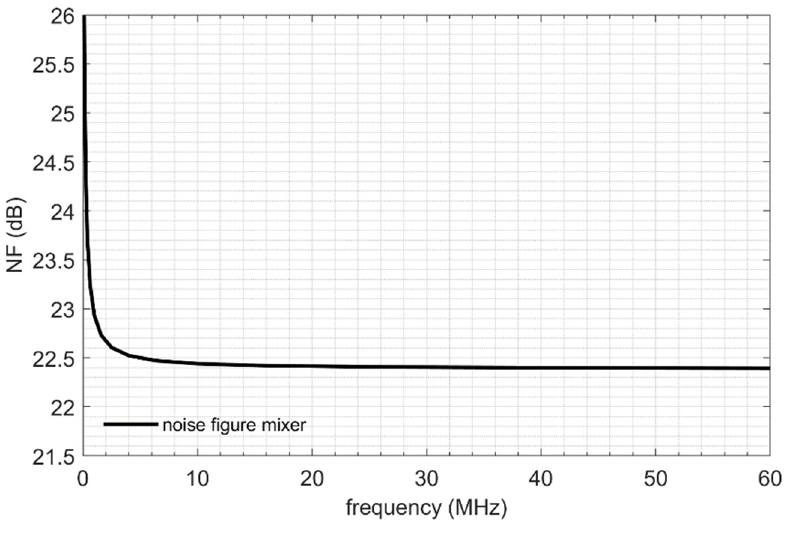
Figure 16. Dsb noise figure of the mixer.